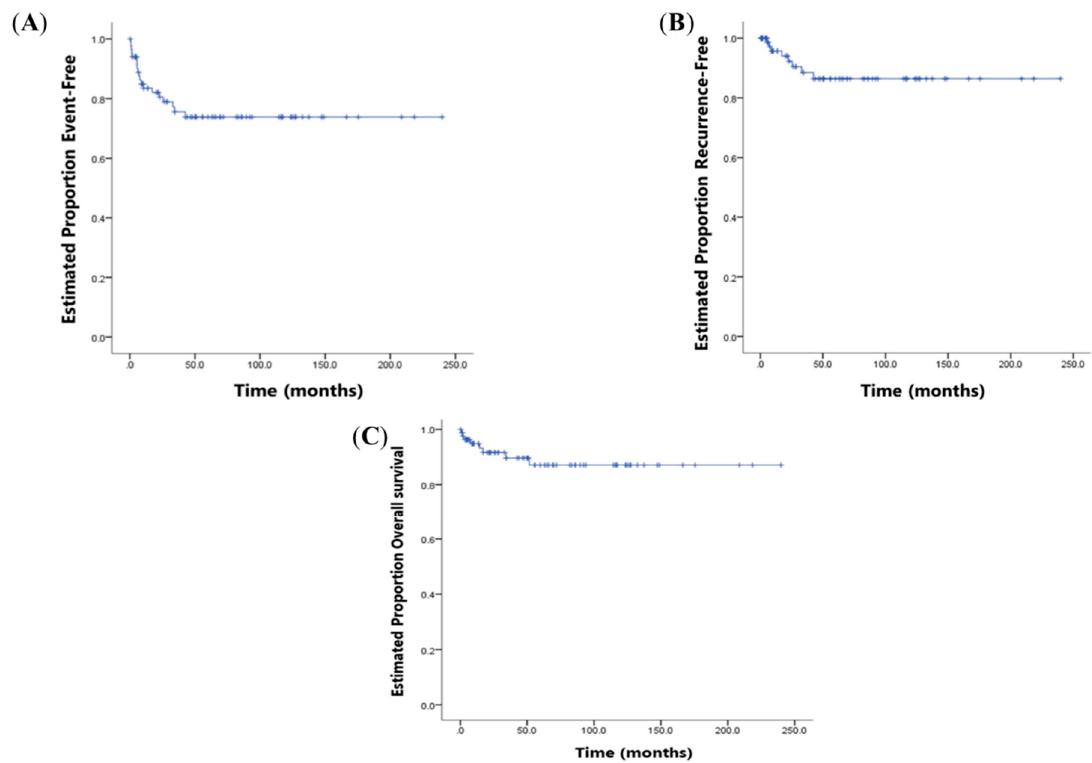
Figure 1. Overall cumulative survival curves for event-free survival ( A ), recurrence-free survival ( B ), and overall survival ( C ) in 84 patients with hepatoblastoma.